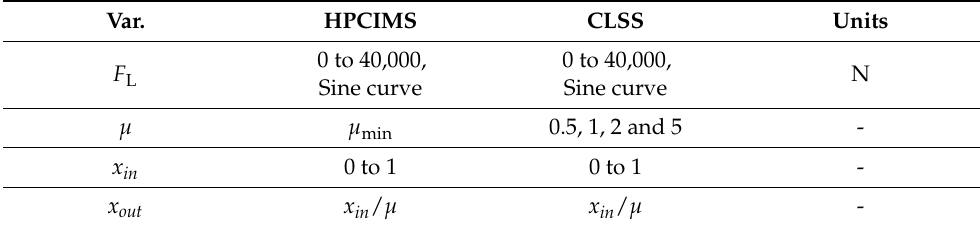
Table 2. The variable parameters of the two systems.